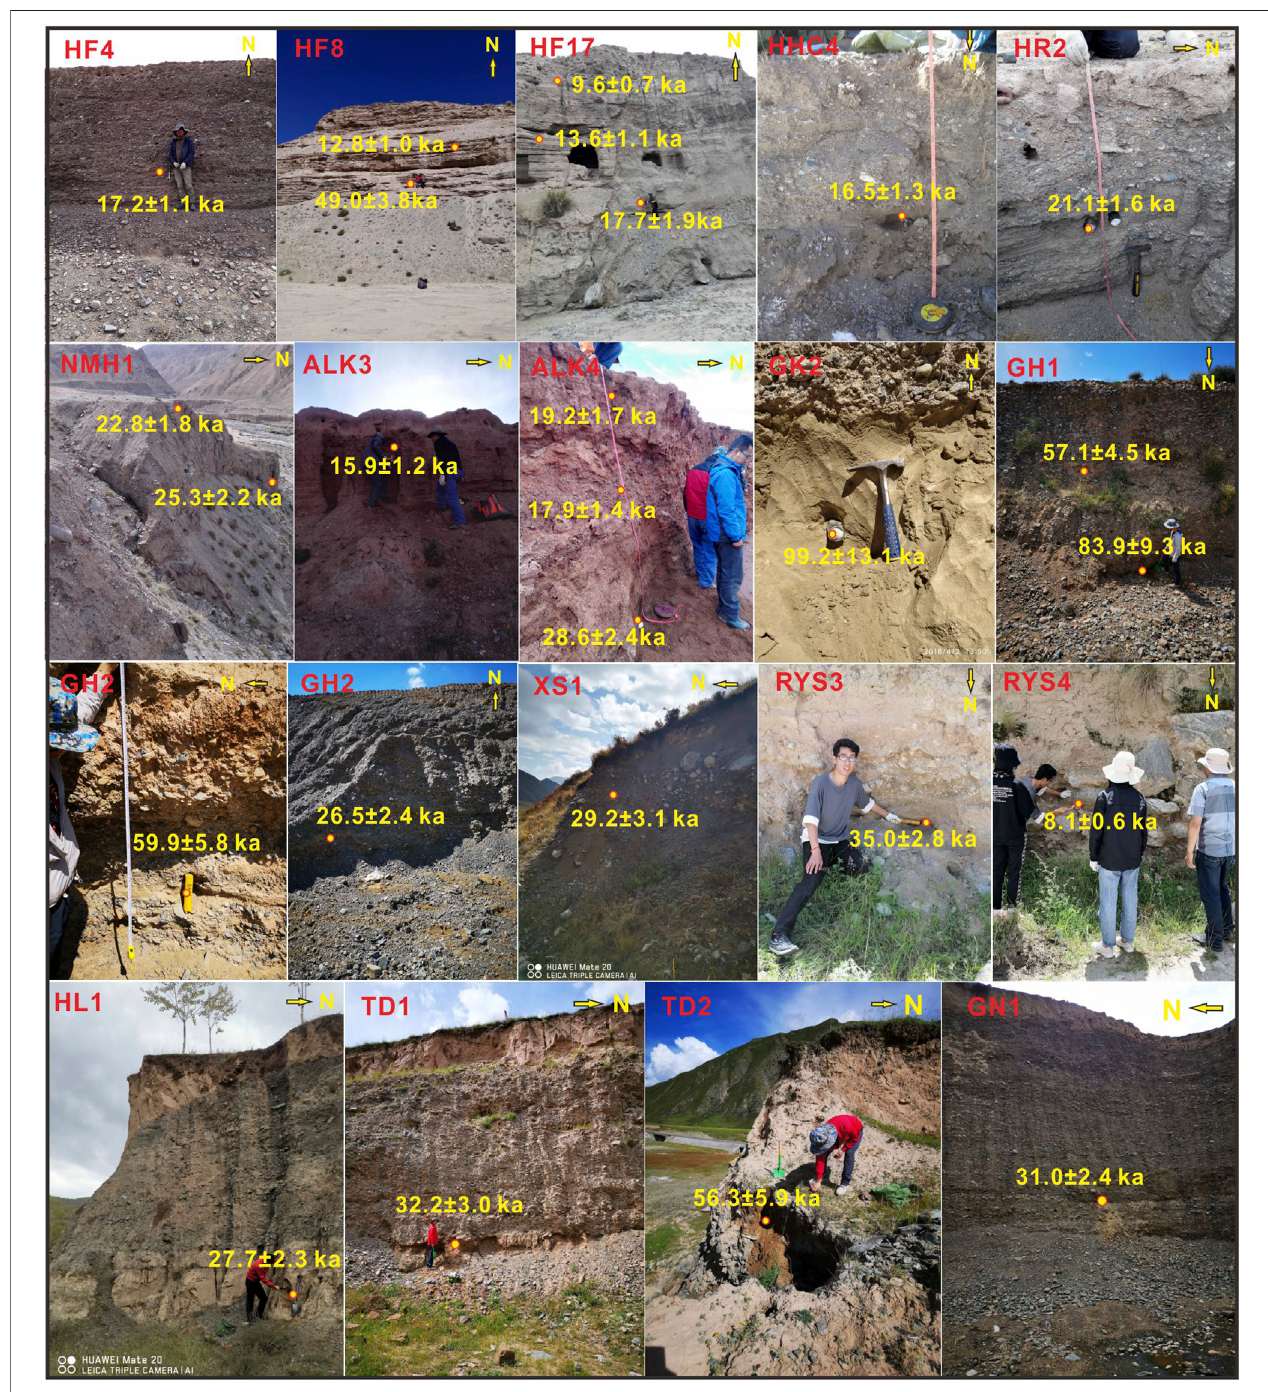
FIGURE 2 | Photos showing pro fi le sedimentary features of all alluvial sections involved in the current study and sampling layers and their corresponding dating results.